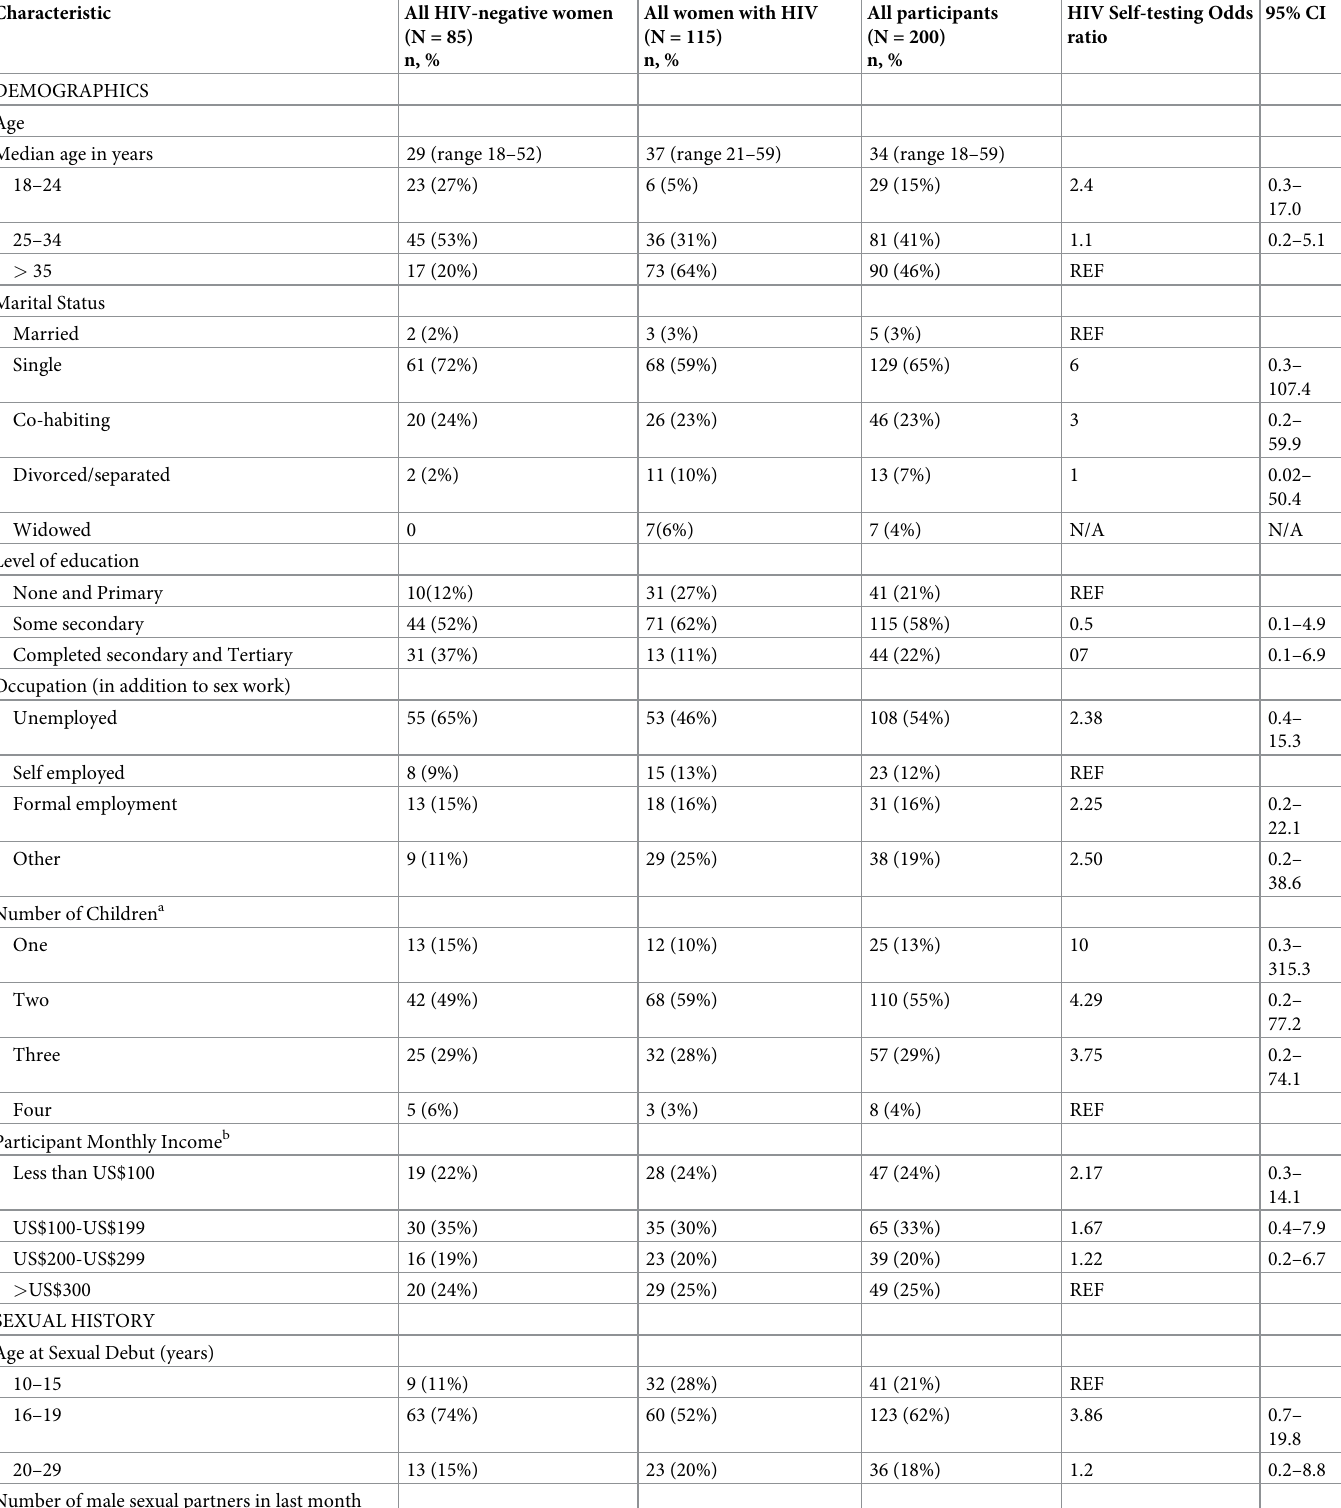
Table 1. Participants’ baseline